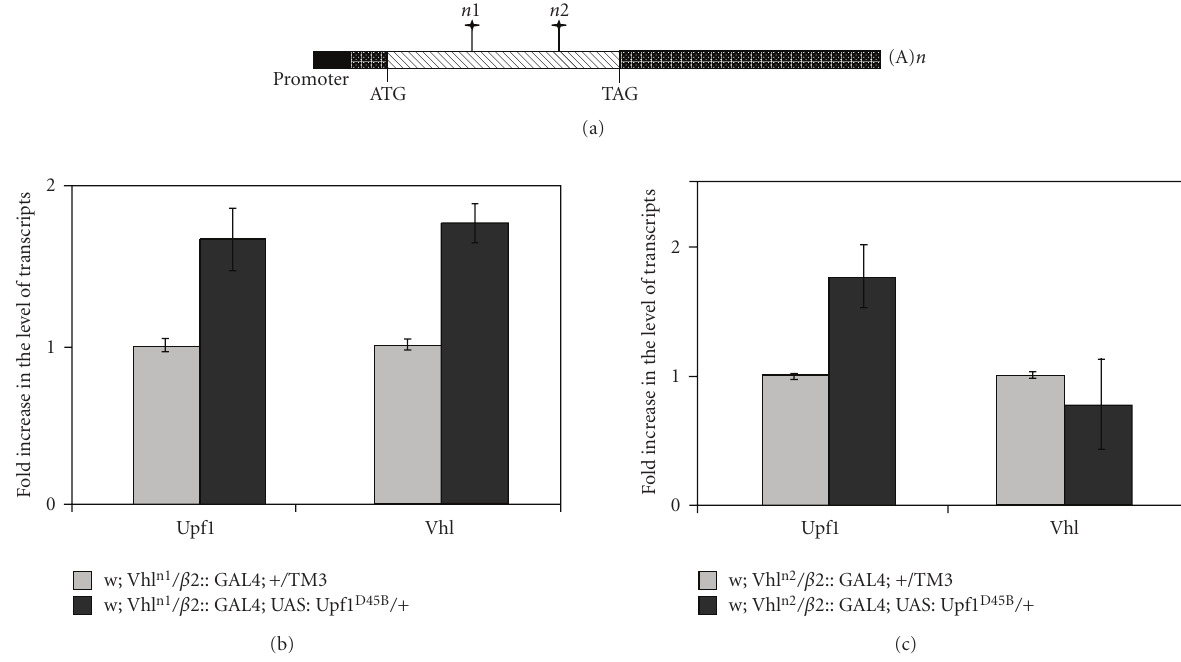
Figure 2: QPCR to measure the levels of transgenic Vhl lines. (a) Schematic map of the Vhl gene. Black rectangles represent the promoter region; hatched box represents the coding region; punctated boxes represent untranslated regions. The position of the point mutations n 1 and n 2 are indicated with vertical lines marked with a star. (b) and (c) We compared the levels of Vhl and Upf1 transcripts in flies that were heterozygous for Vhl nonsense alleles and for Upf1 D 45 B . No increase of Vhl transcript in transgenic UAS: Vhl n 2 line was observed under the inhibition of NMD pathway whereas the UAS: Vhl n 1 transgenic line showed a 1.8 accumulation of nonsense-containing Vhl mRNA. The experiment was repeated three